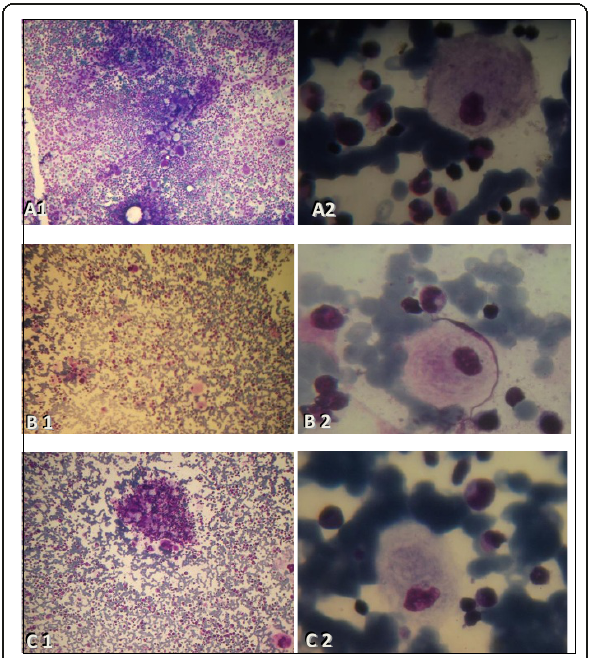
Figure 1 Micorscopic images of Gaucher cells of the three studied GD patients: A cell with a ‘’ sandpaper ’’ appearance was evident . A: Myelogram of Case 1: microscopic image of Gaucher cells (A1: MGG, X10) and (A2: MGG, X100). B: Myelogram of case 2: microscopic image of Gaucher cells (B1: MGG, X10) and (B2: MGG, X100). C: Myelogram of Case 3: microscopic image of Gaucher cells (C1: MGG, X10) and (C2: MGG, X100). Abbreviation: MGG; May- Grünwald Giemsa